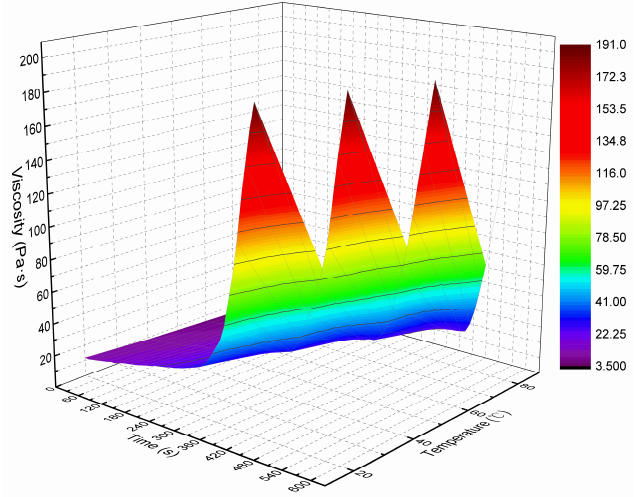
Figure 19. The relationship of viscosity-temperature-time of the HGTGS.